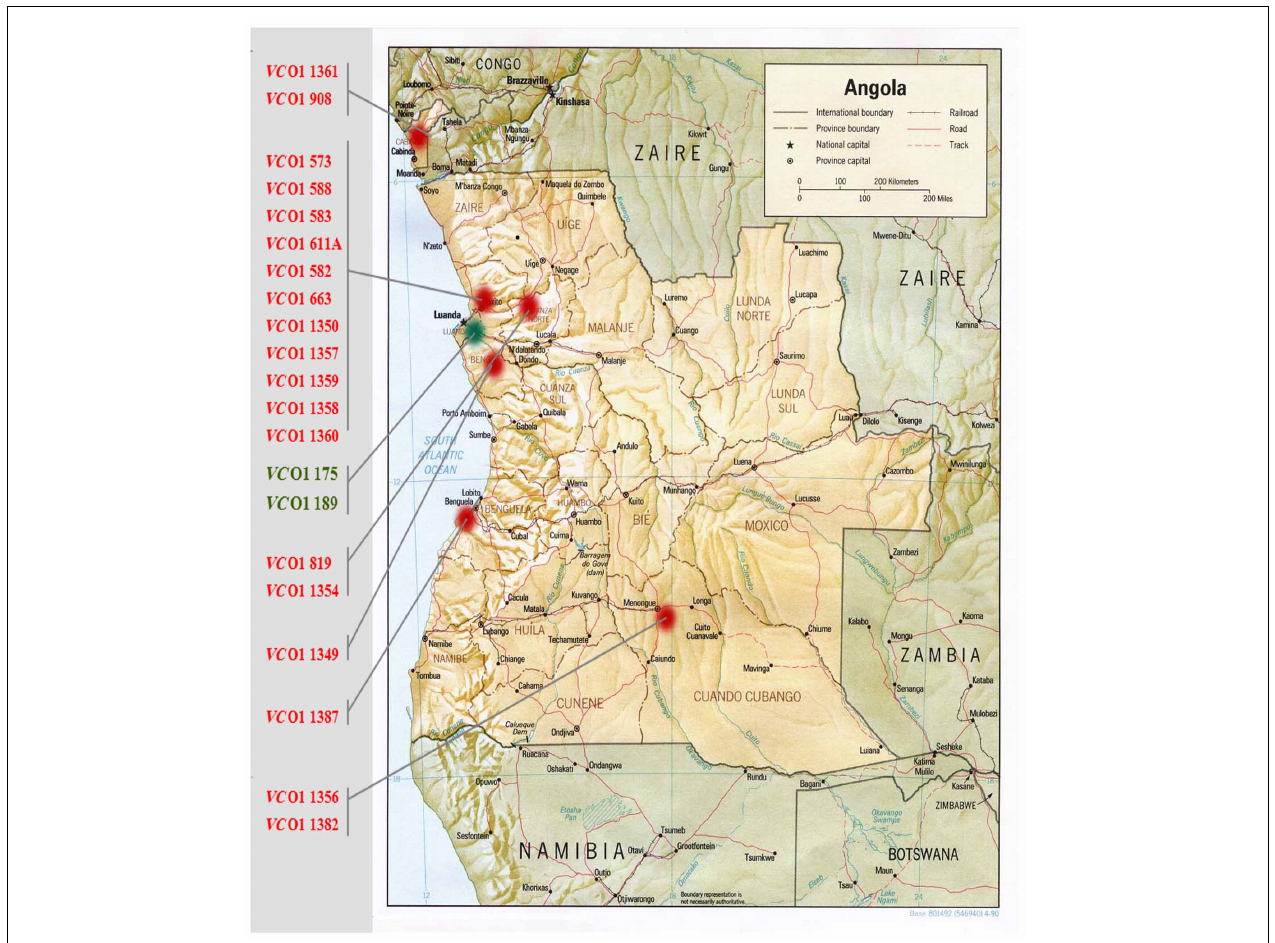
FIGURE 1 | Map of Angola showing the locations of V. cholerae O1 isolation in this analysis. Strains isolated during the 1992–1996 epidemics are indicated in red, strains isolated during 2006 epidemics are indicated in